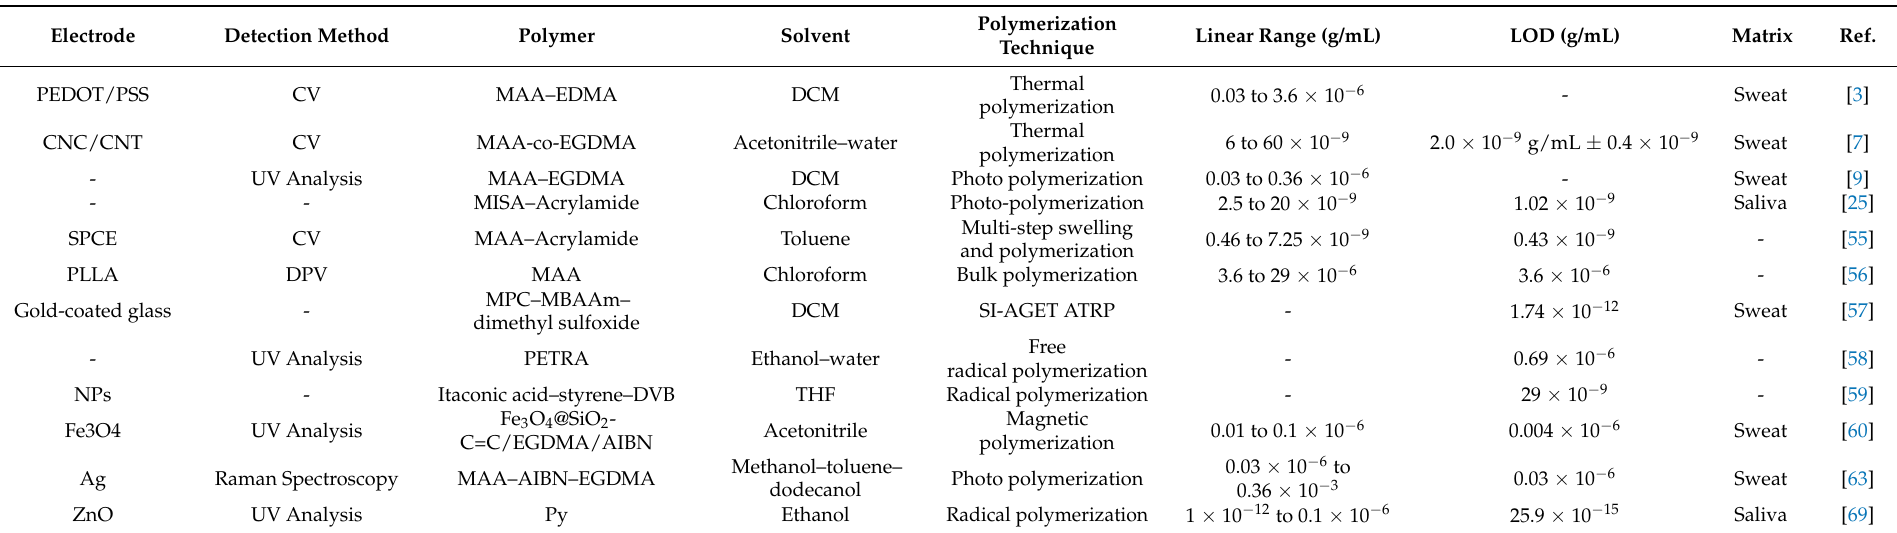
Table 3. Summary of MIP formation via bulk imprinting